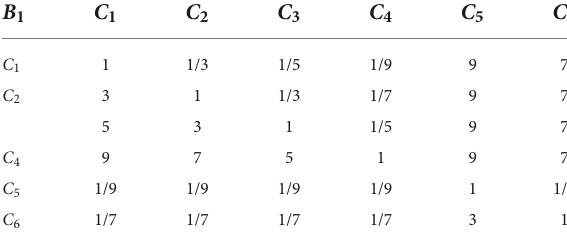
TABLE 4 Judgment matrix of emissions versus